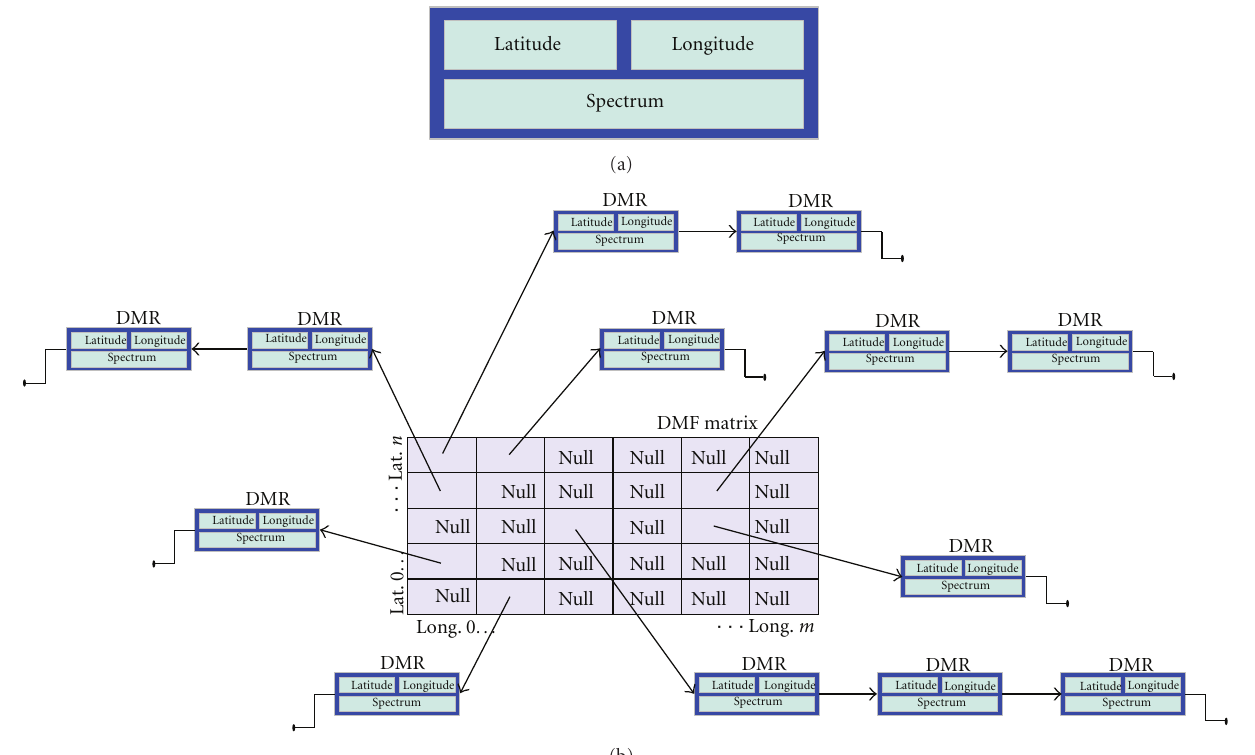
Figure 1: (a) Representation of the DMR record; (b) representation of the DMF